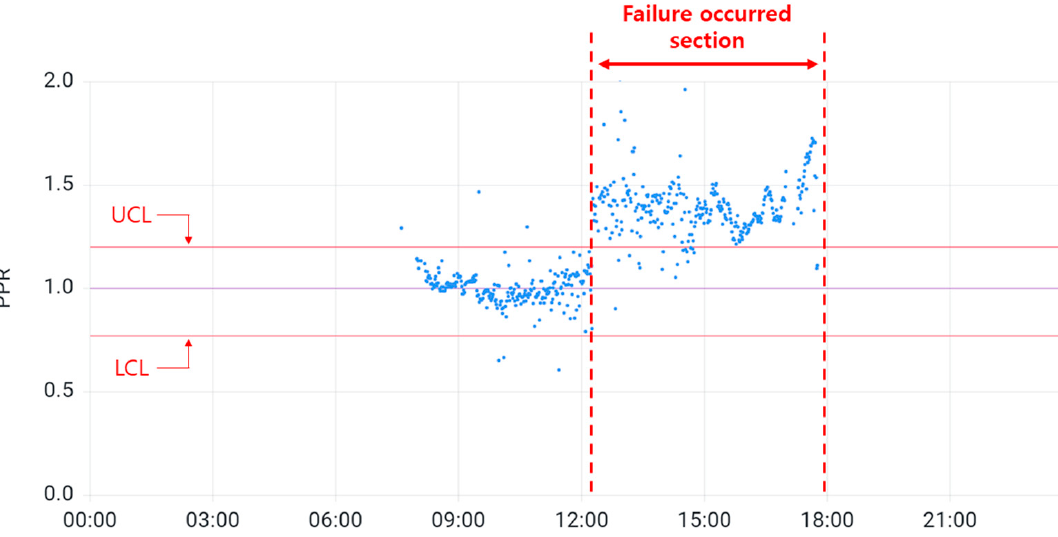
Figure 10. PPR in abnormal operation.